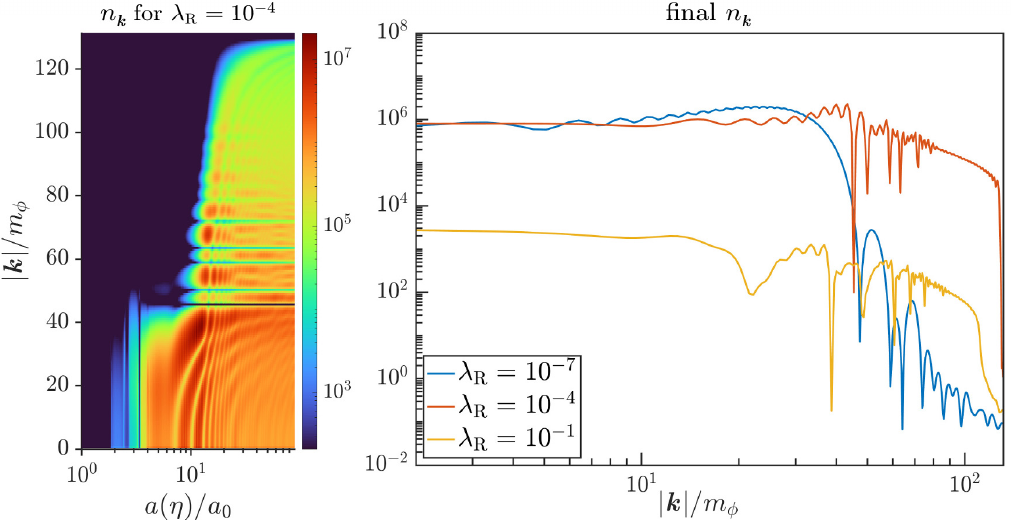
Figure 5 . A contour plot of the comoving particle number density n k for λ R = 10 − 4 (left panel), and the final comoving particle number density n k ( η end ) as a function of momentum for λ R ∈ { 10 − 7 , 10 − 4 , 10 − 1 } (right panel). Both plots have ¯ ξ R = 50 and Γ = 0